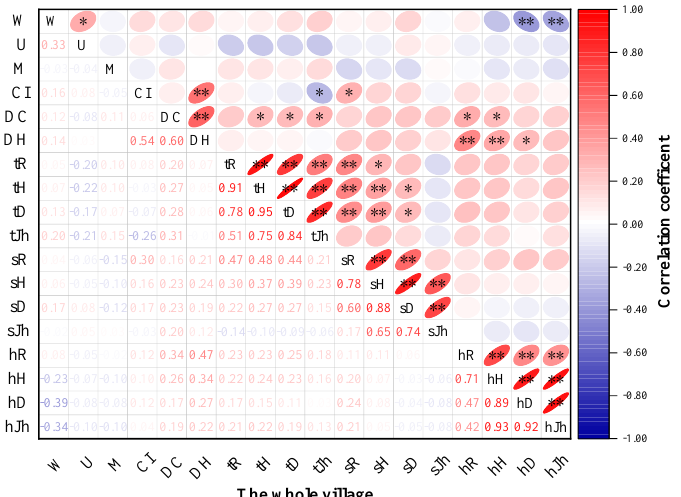
Figure 5. Correlation between plant community structure and species diversity in traditional villages in karst topographic regions of the Zunyi. Note: R : Margalef index; H : Shannon-Wiener diversity index; D : Simpson index; Jh : Pielou evenness index; t , s and h before diversity index are trees, shrubs and herbs respectively, e.g tR is tree layer R , * indicates significant correlation ( p < 0.05), ** indicates highly significant correlation ( p < 0.01) (same below).